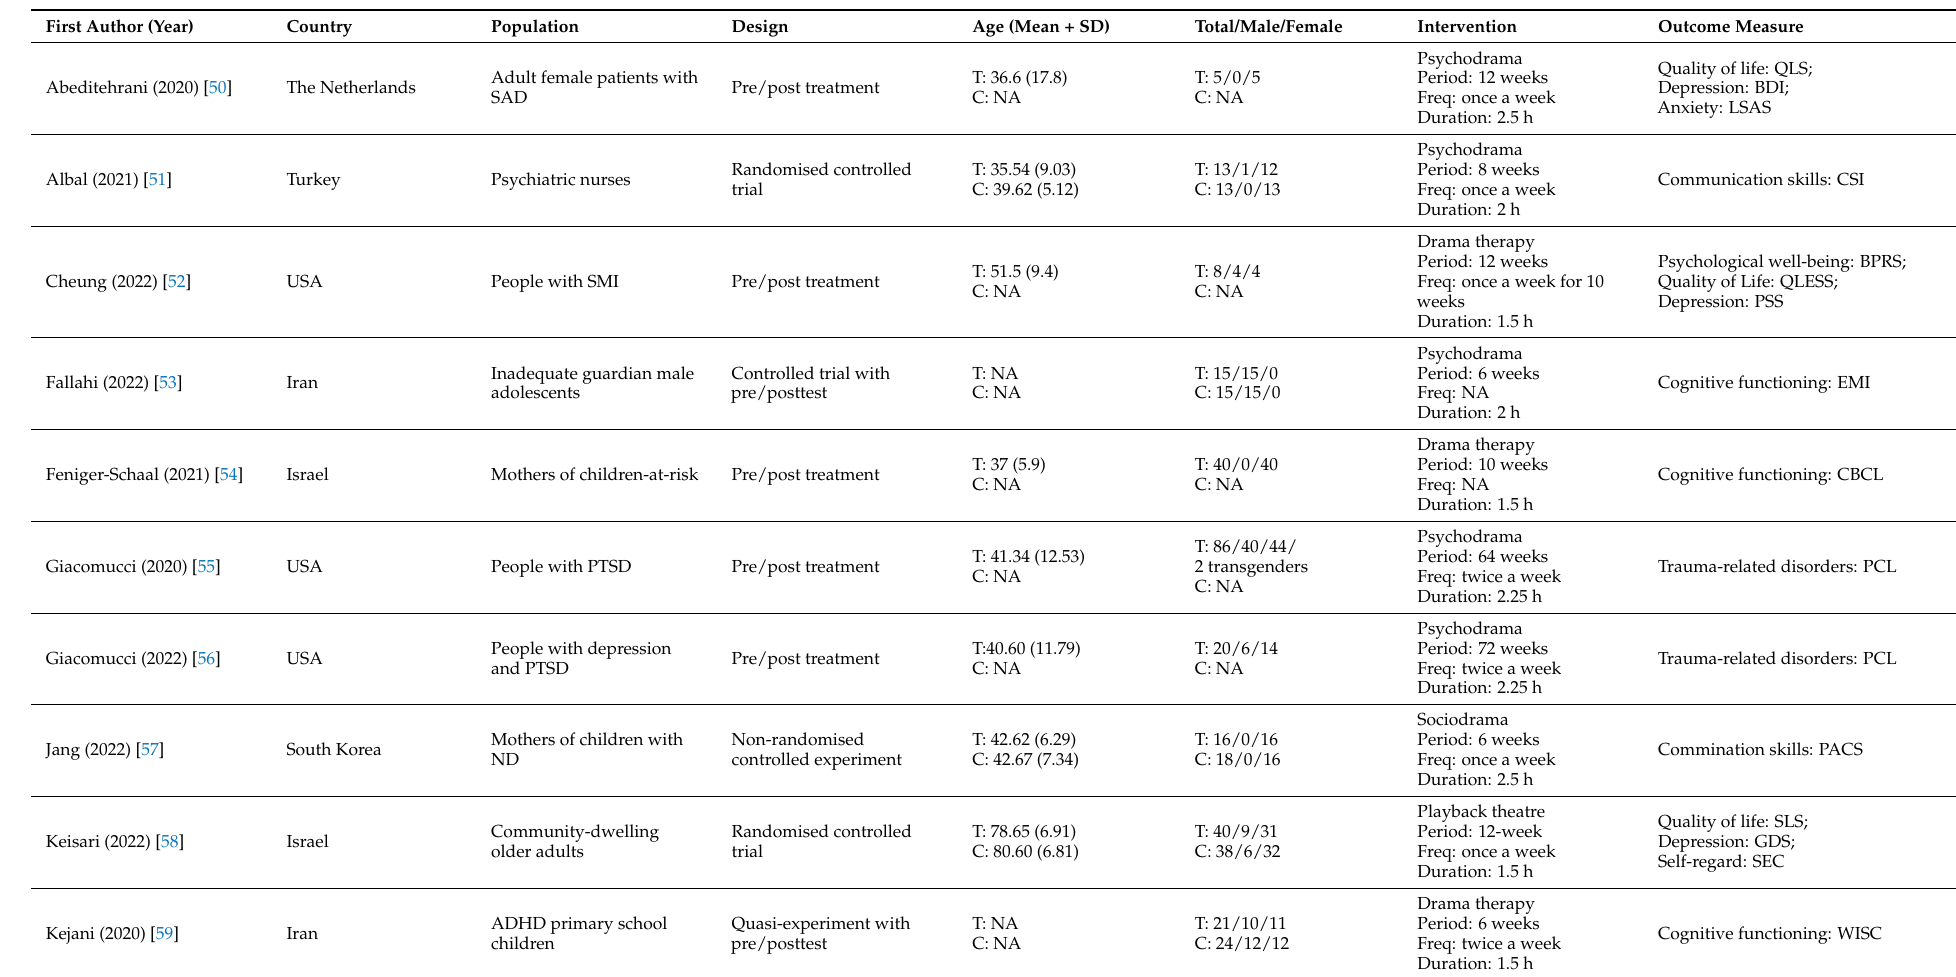
Table 2. Characteristics of the studies included in the